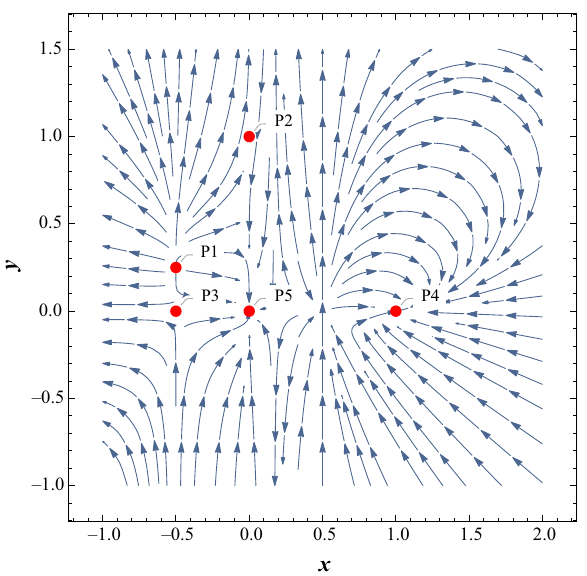
Fig. 2 Phase-space trajectories on the x − y plane for STG. The red dot corresponds to the critical point